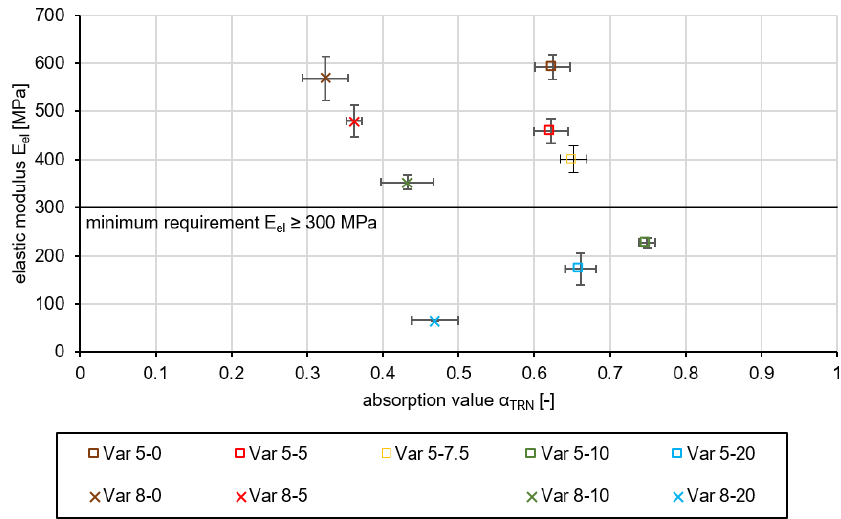
Figure 9. Representation of the elastic moduli across the absorption values of all tested